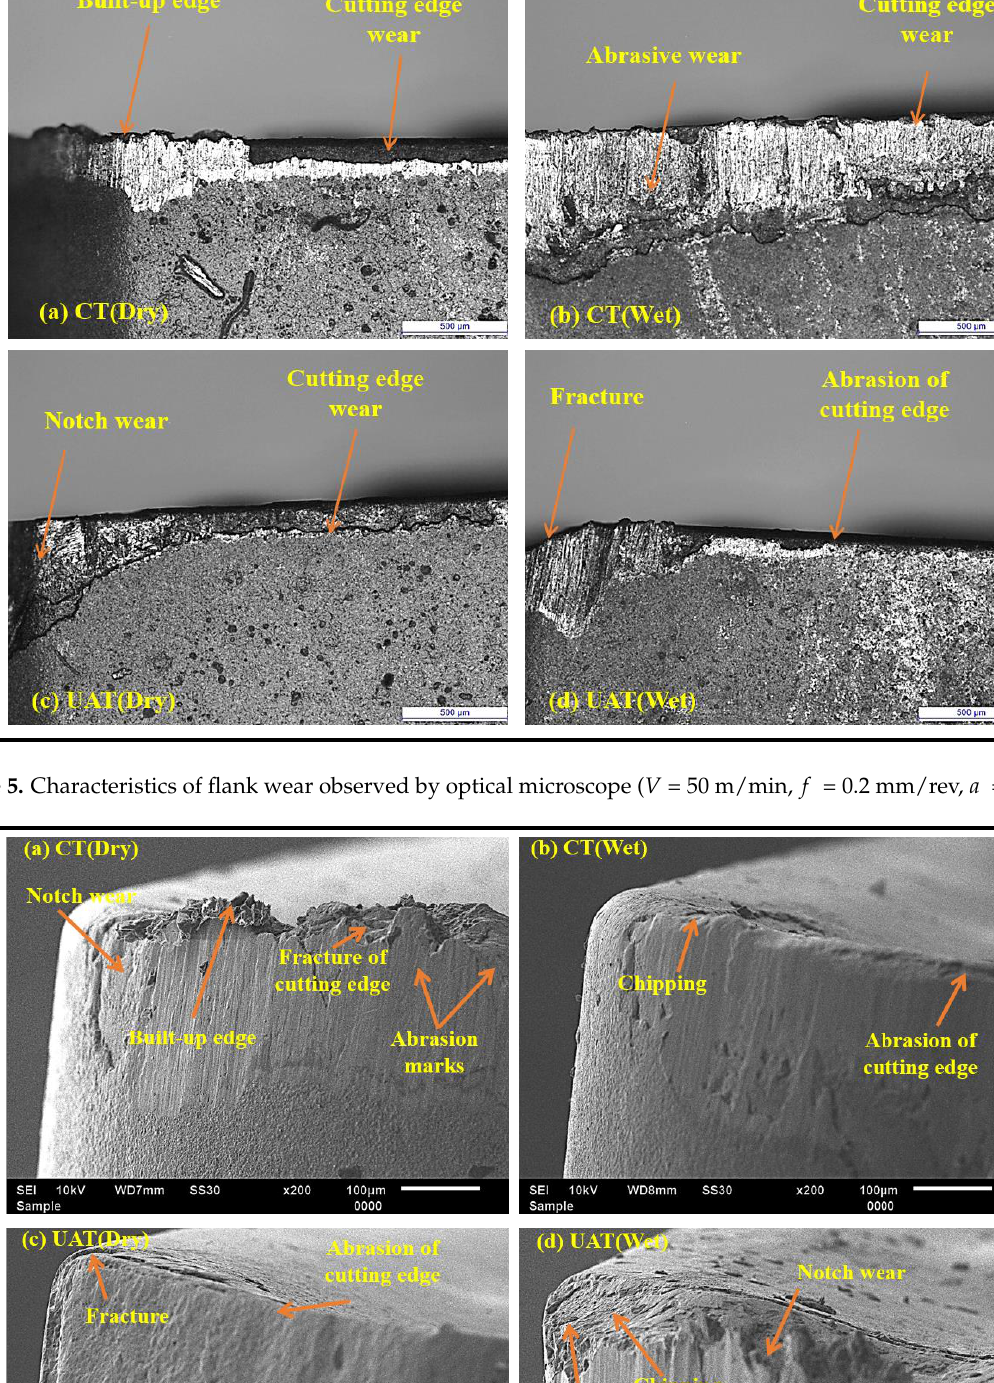
Figure 4. Variation in flank wear with machining time in CT and UAT under dry and wet condi-